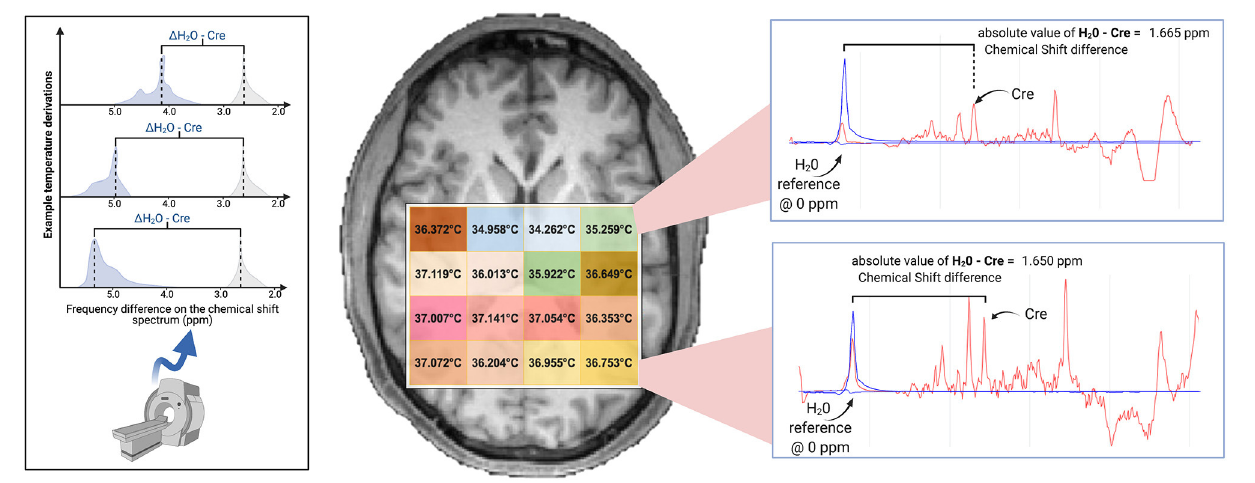
FIGURE 1 | Brain temperature can be non-invasively derived from volumetric magnetic resonance spectroscopic imaging (MRSI) data by calculating the frequency difference between the temperature-sensitive water peak and one or more metabolite peaks that are temperature-insensitive ( left * ). When using creatine as the reference, voxel-level brain temperature can be calculated according to the following equation: T CRE = − 102.61( 1 H20 − CRE ) + 206.1 ◦ C, 1 H20 − CRE = chemical shift difference between the creatine and water resonances. Example T CRE calculations are provided for a participant’s single tissue slice ( right ). Representative spectra illustrate 1 H20 − CRE derivations, with plots depicting a water-suppressed metabolite spectrum ( red line ), with an overlay that indicates the location of the reference water signal ( blue line) . Spectral plots were created within the Metabolite Imaging and Data Analysis System (MIDAS) software package, and the figure was created using BioRender. * Adapted from Dehkharghani et al.